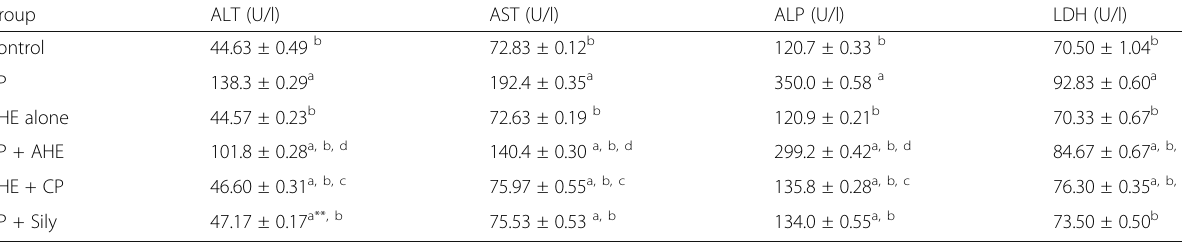
Table 2 Effect of cisplatin (CP) and different treatments of AHE on liver biomarkers in serum Group